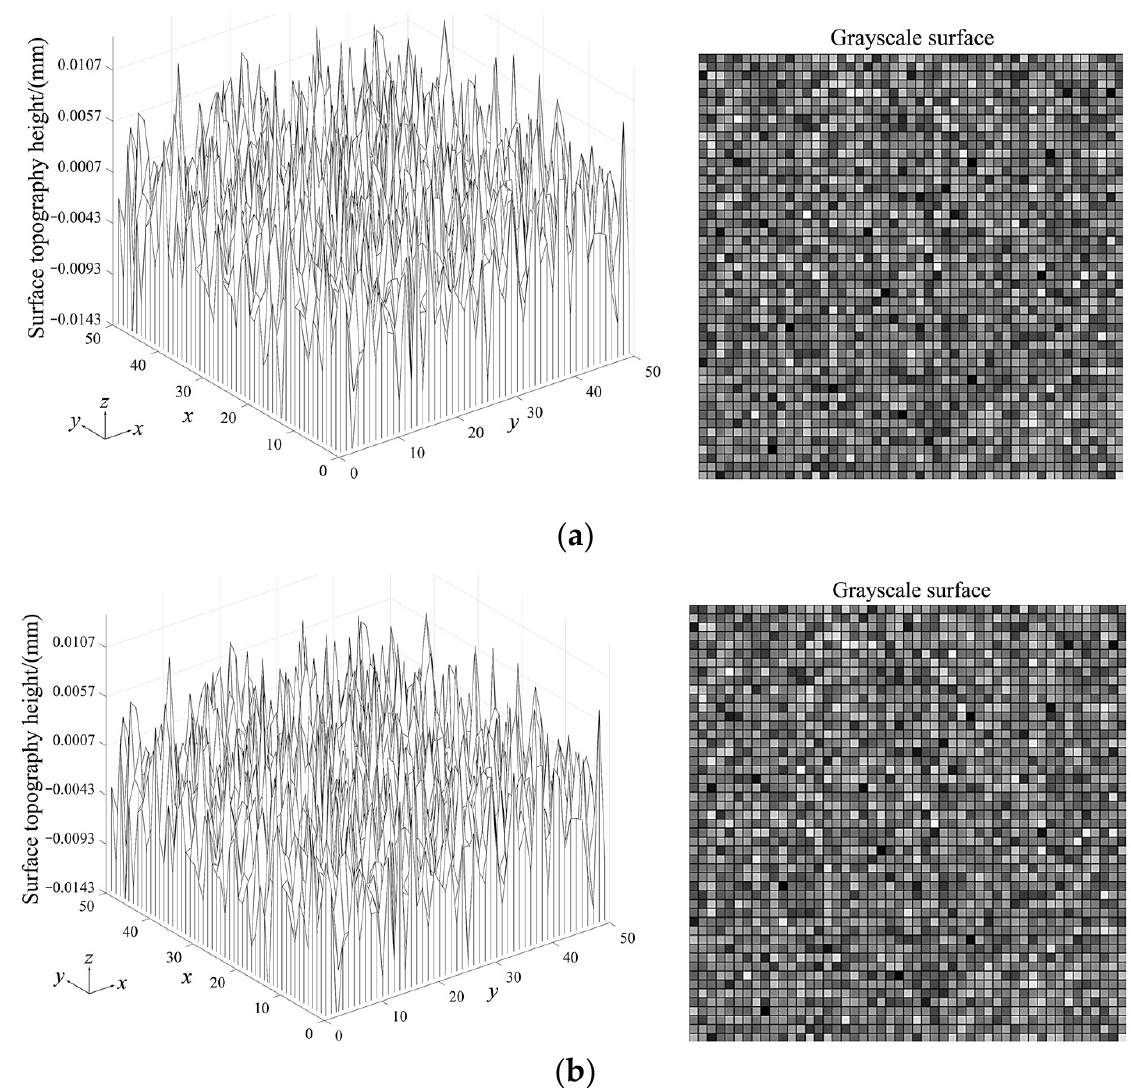
Figure 9. Wear cycle iterative calculation flowchart. ( a ) Surface topography when friction time is 0 min; ( b ) surface topography when friction time is 60 min.